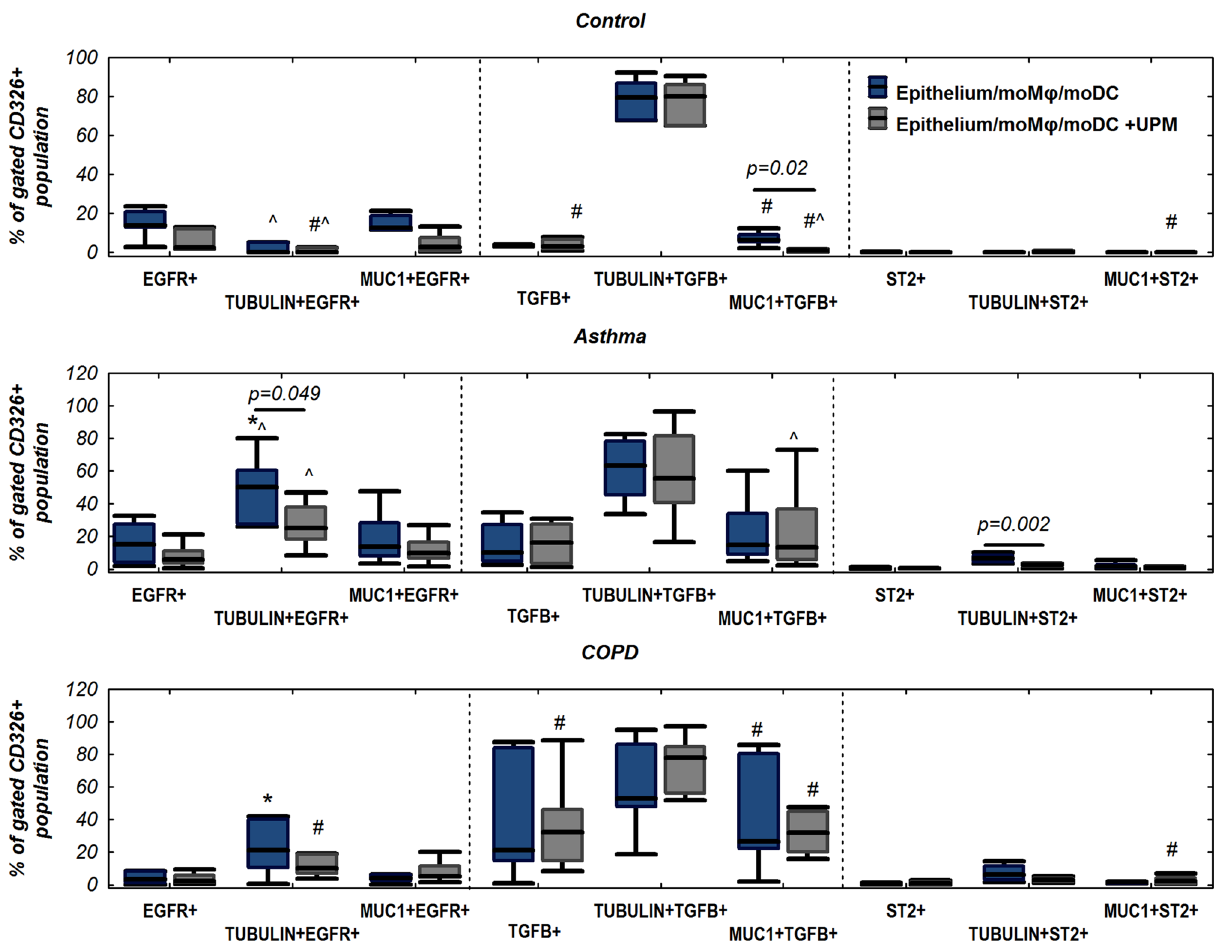
Figure 13. EGFR, TGFβ, and ST2 expression on air–liquid interface (ALI) cultured epithelium upon monocyte derived macrophages (moMφs) and monocyte derived dendritic cells (moDCs), co-cultivation with or without 24 h UPM exposure in control, asthma, or COPD groups. p value < 0.05 calculated using in Mann–Whitney U test: ^ asthma versus control, # COPD versus control, *asthma versus We found that moMφs without UPM treatment produced different cytokines in healthy people and patients with obstructive lung diseases—they do not produce IL-6 in asthma and COPD and secrete more IL-8 in COPD. The results of our study indicated that moMφs of patients with asthma and COPD vary in terms of reaction to UPM exposure from controls suggesting their changed ability for proper protective function in cooperation with epithelial cells after air pollutant response. Our study showed that the integrity of the cellular barrier was increased in epithelium/moMφs co-cultures compared to epithelium alone of asthma patients; this effect was not UPM-depended. In other in vitro models, the addition of macrophages (THP-1 cell line) did not induce TEER values in pulmonary epithelial cells (Calu-3 cell line) co-cultured with pulmonary endothelial cells (HPMEC-ST1.6R cell line) 49 . In contrast, other authors observed significantly lower TEER values using a similar cell culture model 50 . In similar cell culture configura- tions as in our study, Lehman et al. found that TEER values of triple-co-cultures were lower than in epithelial monocultures 51 . We believe that our results partially confirm this observation: the addition of moDCs and/or moMφs to epithelial cells decreased TEER values in controls (with the most profound effect in triple co-cultures) but did not change TEER values in asthma and COPD suggesting that this effect is related to their pathology. The use of macrophages in the in vitro system might cause some epithelial morphological changes. The interactions of the moDCs and/or moMφs within the epithelium may elucidate the decrease of the integrity of tight junctions in control di- and triple co-cultures. The normal epithelial cells (in the control group) are probably less tightly connected to each other after moDCs and/or moMφs co-cultivation due to the development of cell–cell inter- actions in contrast to asthma and COPD where moDCs and/or moMφs co-cultivation with epithelial cells was able to prevent a leakage barrier. It has been shown that moDCs and/or moMφs are able to interact in the triple cell co-culture as a transepithelial network, by building cytoplasmic pseudopodia with epithelium, which might more tightly connect the cells 52 . Our study showed that the interactions between epithelium and macrophages/ DCs are different in obstructive lung diseases than in the control group. We can only speculate that this effect is related to epithelial cells which were obtained from more environmental, and disease impacted origin than moDCs and moMφs (from peripheral blood). The hyperreactivity of respiratory epithelial cells in obstructive